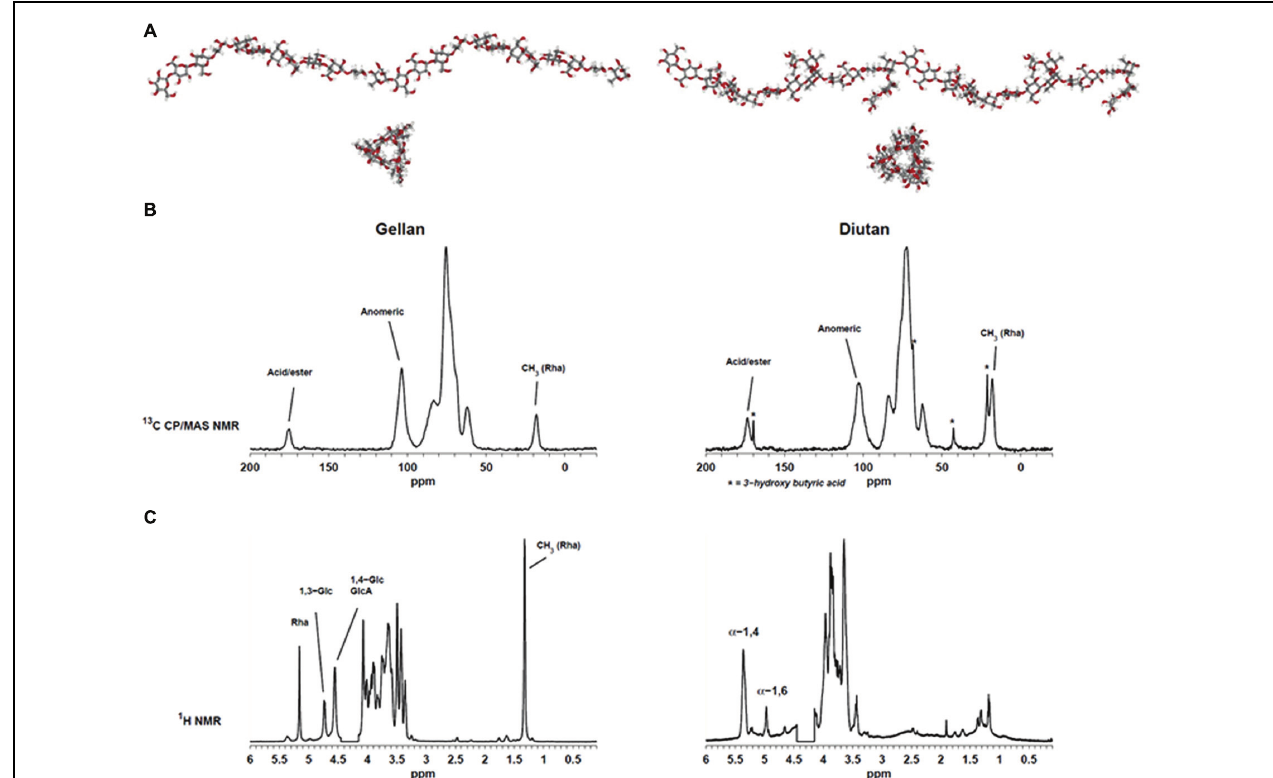
FIGURE 2 | (A) Molecular modeling of gellan (left) and diutan (right). (B) Solid-state 13 C CP/MAS spectra of gellan (left) and diutan (right). (C) 1 H Liquid-state Nuclear Magnetic Resonance (NMR) spectra of gellan (left) and diutan (right). The partly suppressed water resonance (4.15–4.45 ppm) was removed from the 1 H Liquid-state NMR